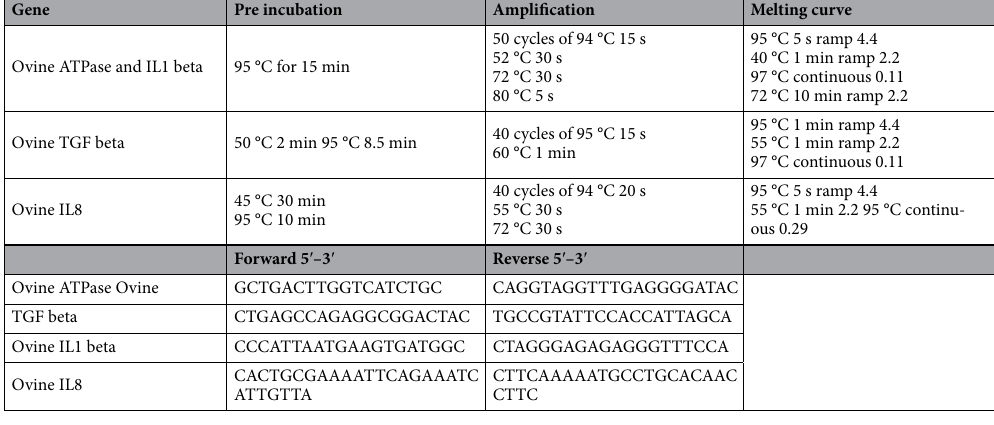
Table 2. qPCR conditions and primer